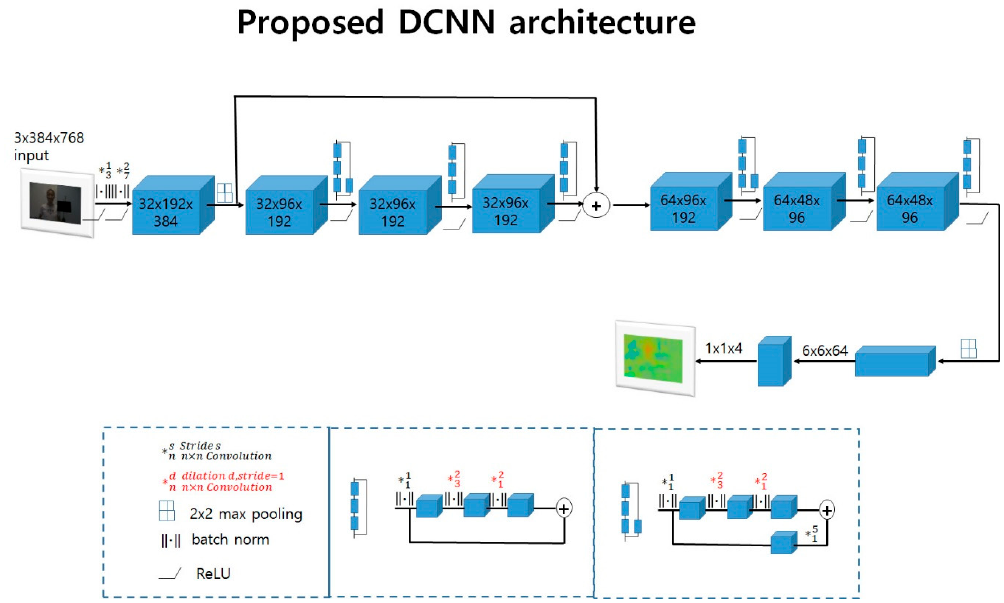
Figure 2. Proposed deep convolutional neural network (DCNN) architecture with pre-activation, atrous convolution, and batch-normalization.